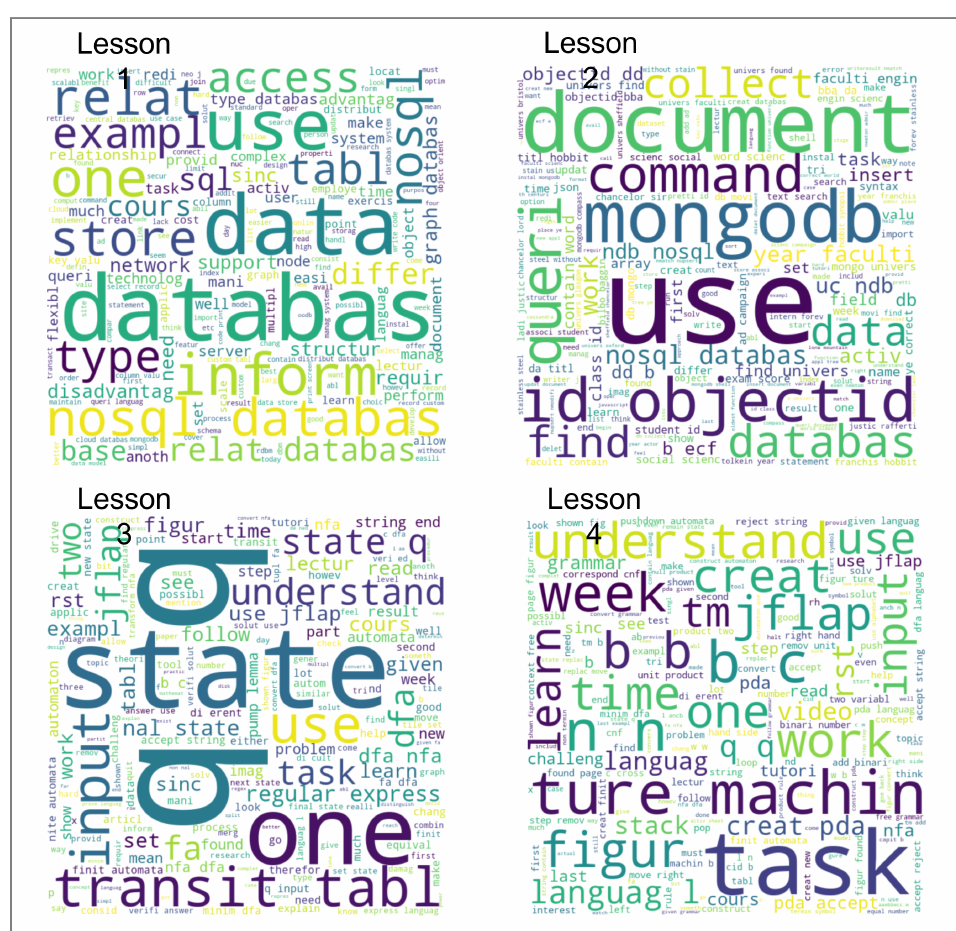
Figure 6. Word cloud of the most frequent words in each